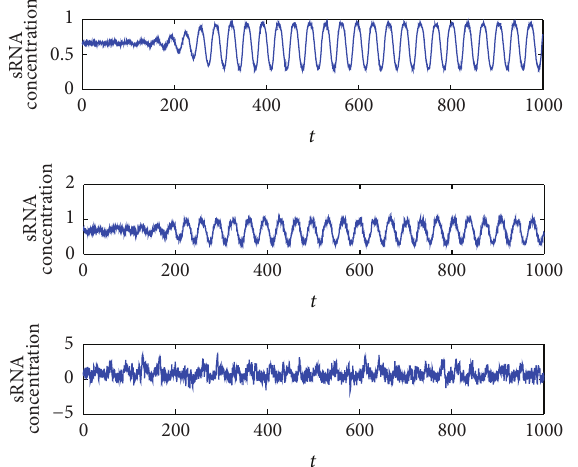
Figure 3: The dynamics of system (1) for different noise intensities: From bottom to top, 𝐷 = 0.8 , 𝐷 = 0.05, and 𝐷 = 0.01 .